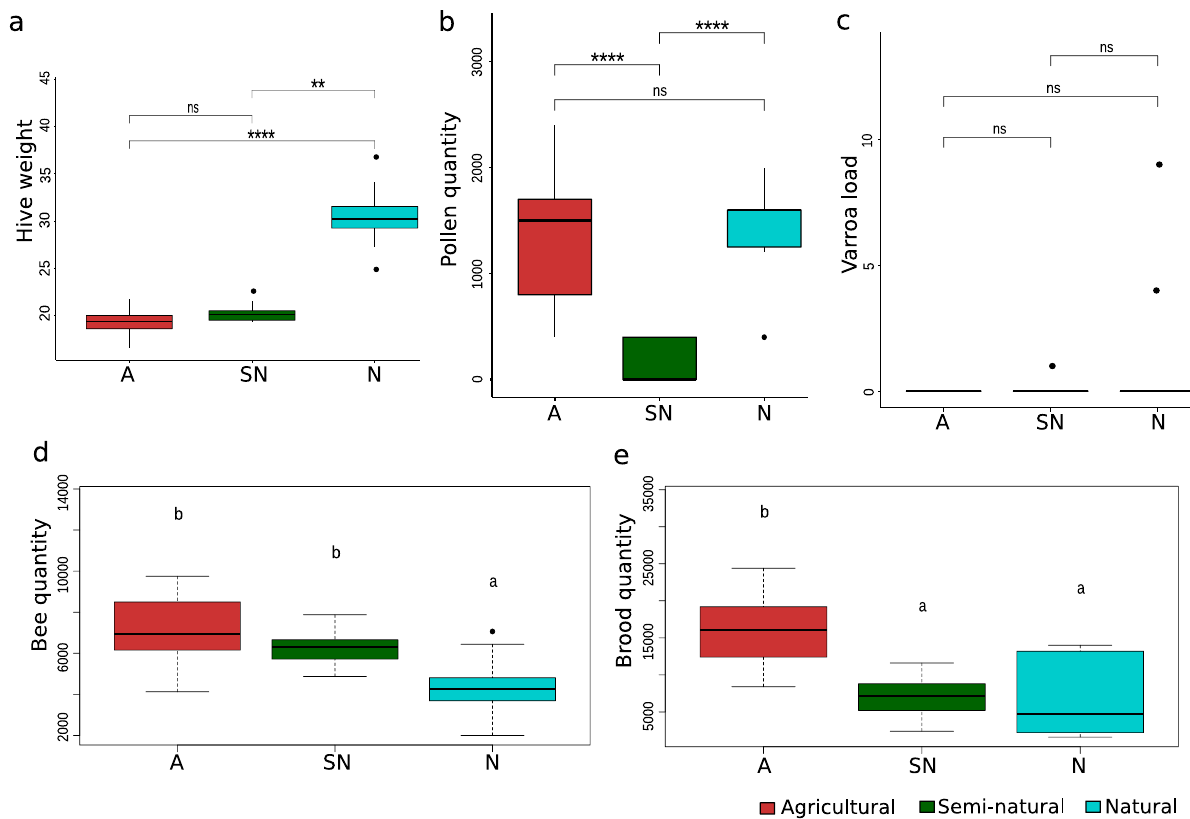
Figure 1. Statistical comparison between environments for colony strength traits and Varroa destructor loads. The top plots ( a – c ) show pairwise Dunn tests with Benjamini–Hochberg correction, with significance expressed as 0 (****), 0.001 (***), 0.01 (**), 0.05 (*), no-significant (ns). The bottom plots ( d , e ) show pairwise post-hoc Tukey’s test, with different letters indicating statistically significant differences. ( a ) Hive weight measured in kilograms (Kruskal–Wallis test, χ 2(2) = 26.58, p < 0.0001). ( b ) Estimated pollen cells per apiary (Kruskal–Wallis test, χ 2(2) = 24.08, p < 0.0001). ( c ) Varroa destructor load measured by the Powdered Sugar method (Kruskal– Wallis test, χ 2(2) = 4.72, p > 0.05). ( d ) Bee population measured as the number of bees per colony (ANOVA, F = 13.64, p < 0.0001; pairwise Tukey, for A vs N p < 0.001, for SN vs N p < 0.05). ( e ) Brood population measured by quantification of brood cells (ANOVA, F = 23.35, p < 0.0001; pairwise Tukey, for A vs SN p < 0.0001, for A vs N p <